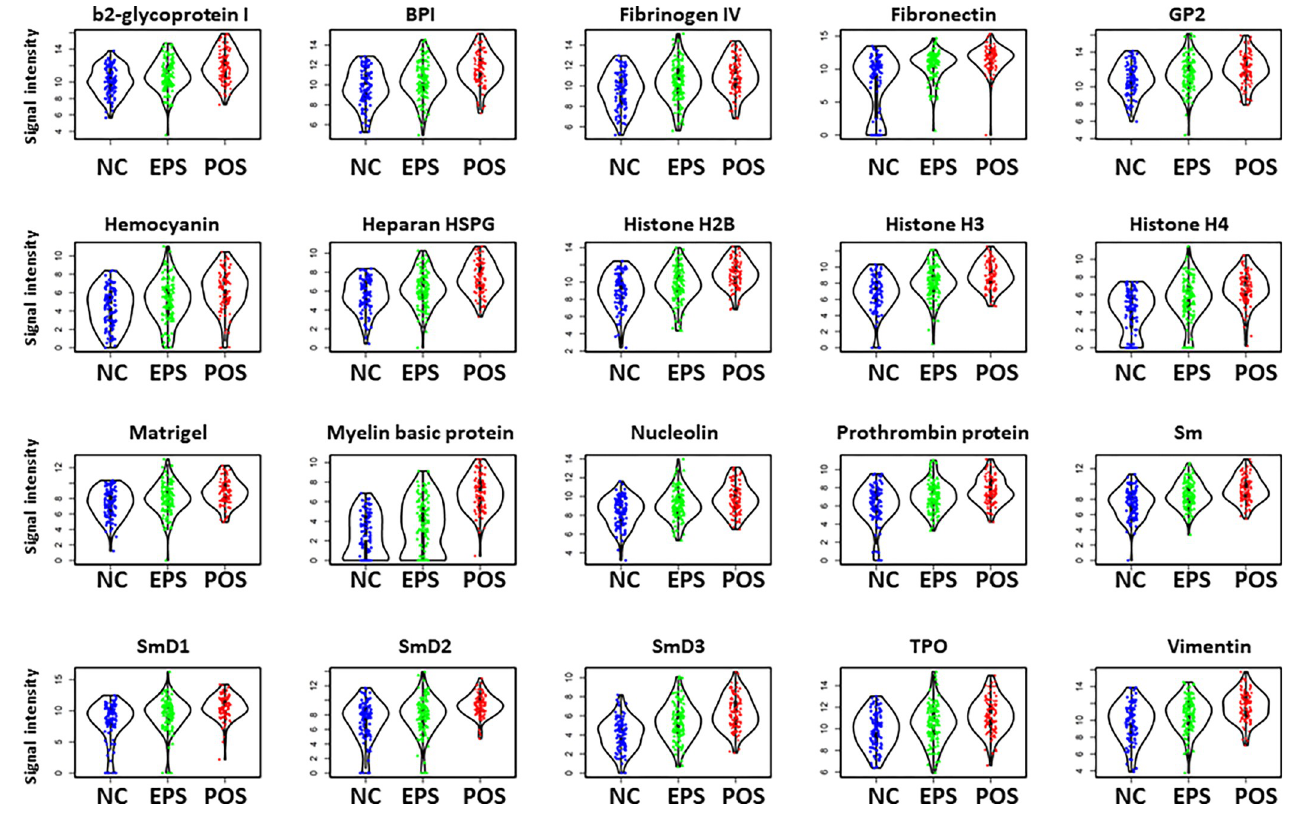
Fig 3. Violin plots generated by GraphPad prism 9 showed 20 IgM autoantibodies are significantly increased in EPS group compared to NC. Meanwhile, they are also significantly elevated in POS group compared with EPS group. Group comparisons were performed by Mann-Whitney